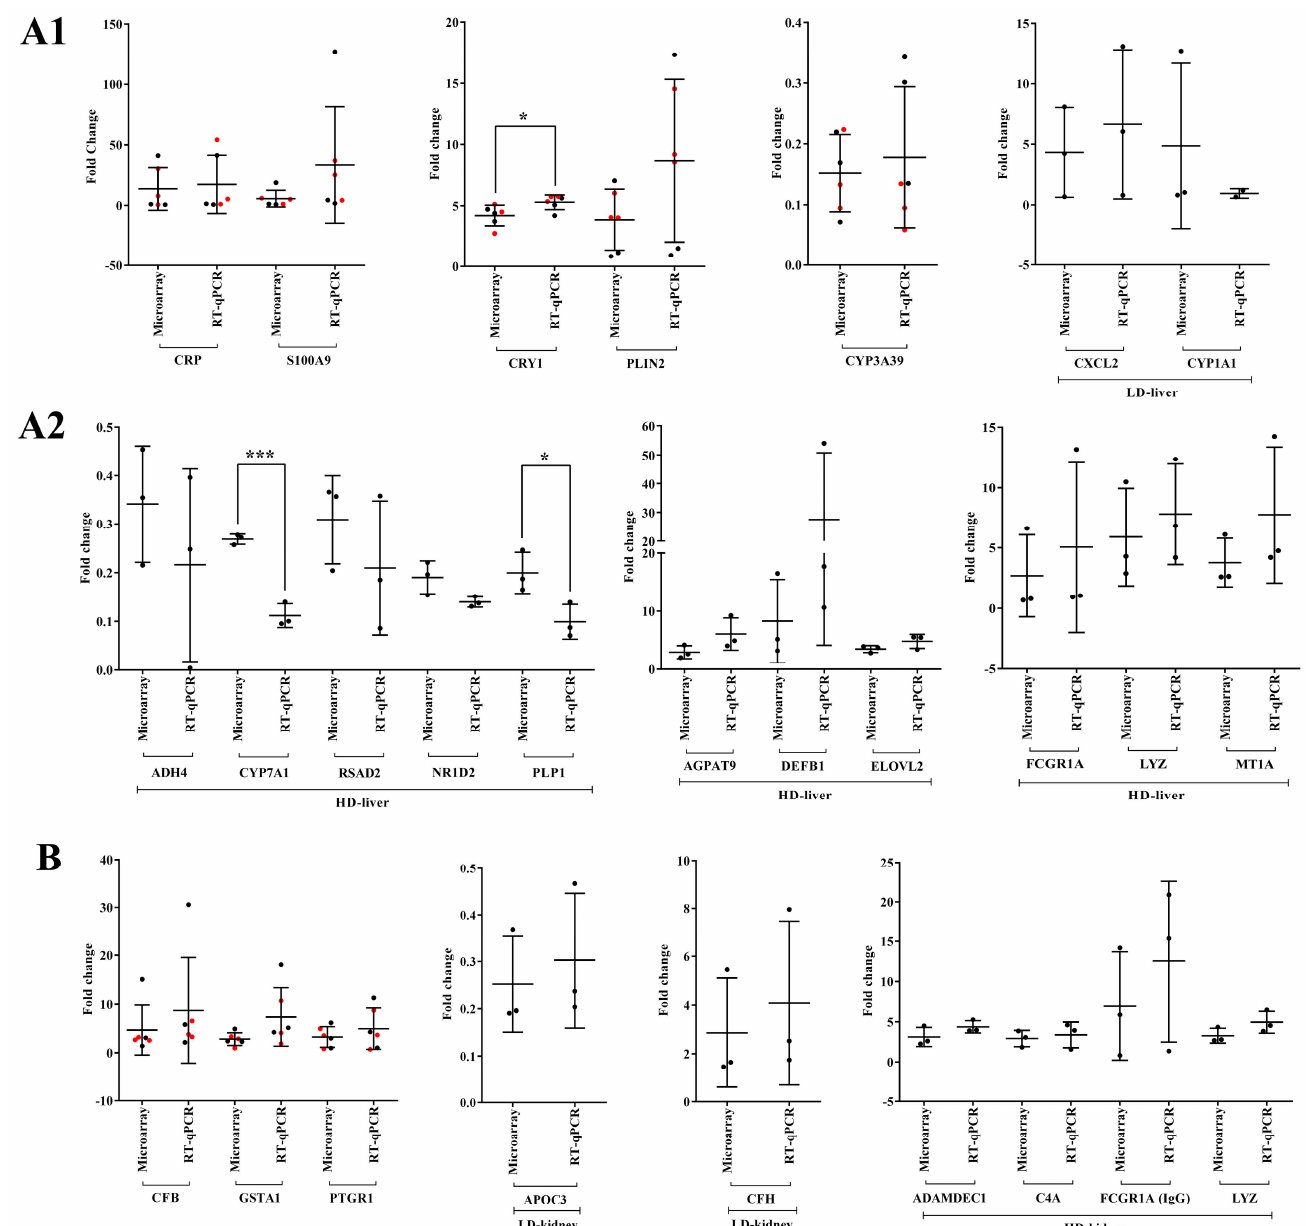
Figure 20. Experimental validation of highly regulated genes in liver and kidney in response to diclofenac treatment. Panel A1,A2: Liver-regulated genes in response to low- and high-dose diclofenac treatments. Panel B: Highly regulated genes in the kidney. The y-axis indicates the individual fold changes in treated animals (diclofenac-treated vs. controls). Fold changes obtained from high-dose treatments are marked in red color. Data are Fold change ± SD. * p < 0.05, *** p < 0.001. LD = low-dose, HD = high-dose.